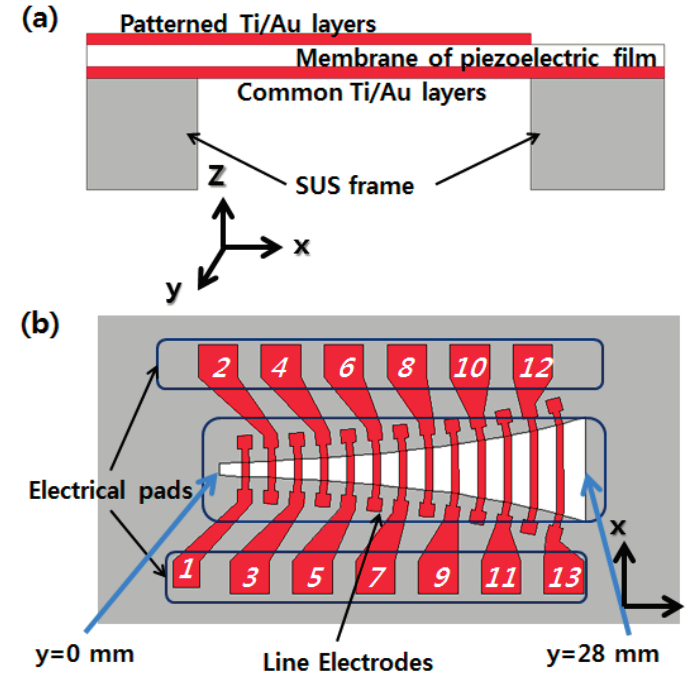
Figure 1. 2D schematic of membrane part design of PAC: from side view ( a ); from top view ( b ).